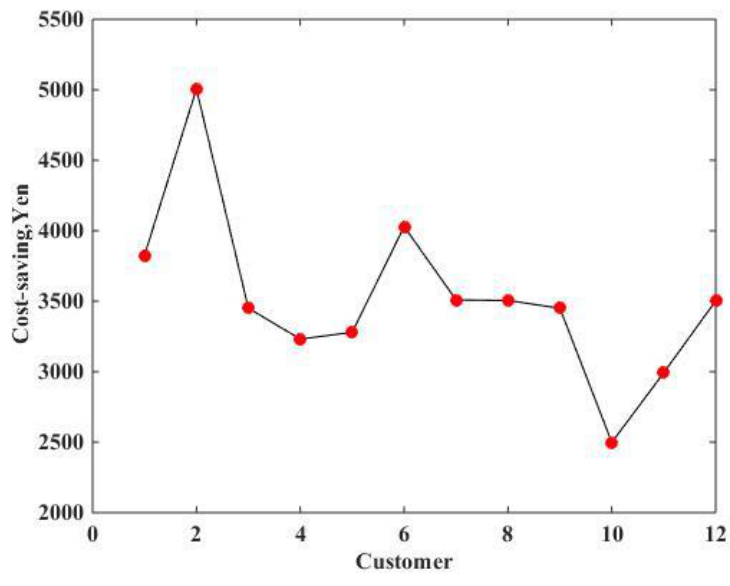
Figure 6. Cost savings performance among